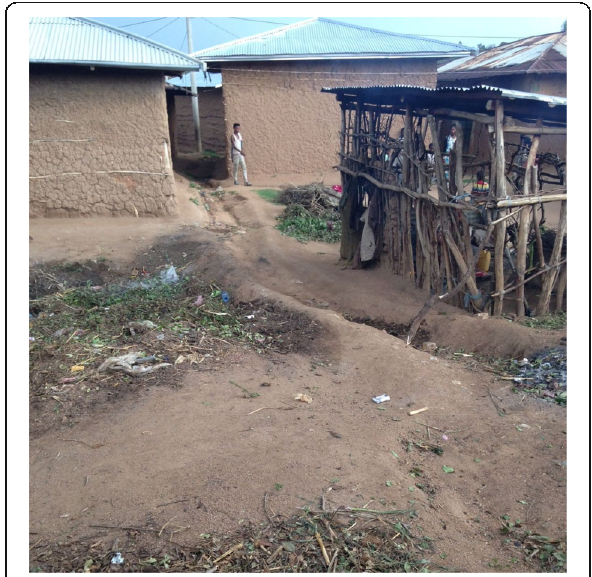
Fig. 4 An example of a well-kept domestic environment, with garbage and feces swept into discrete dump piles; a few minutes after this picture was taken, a large group of young children began to play a game on the rubbish